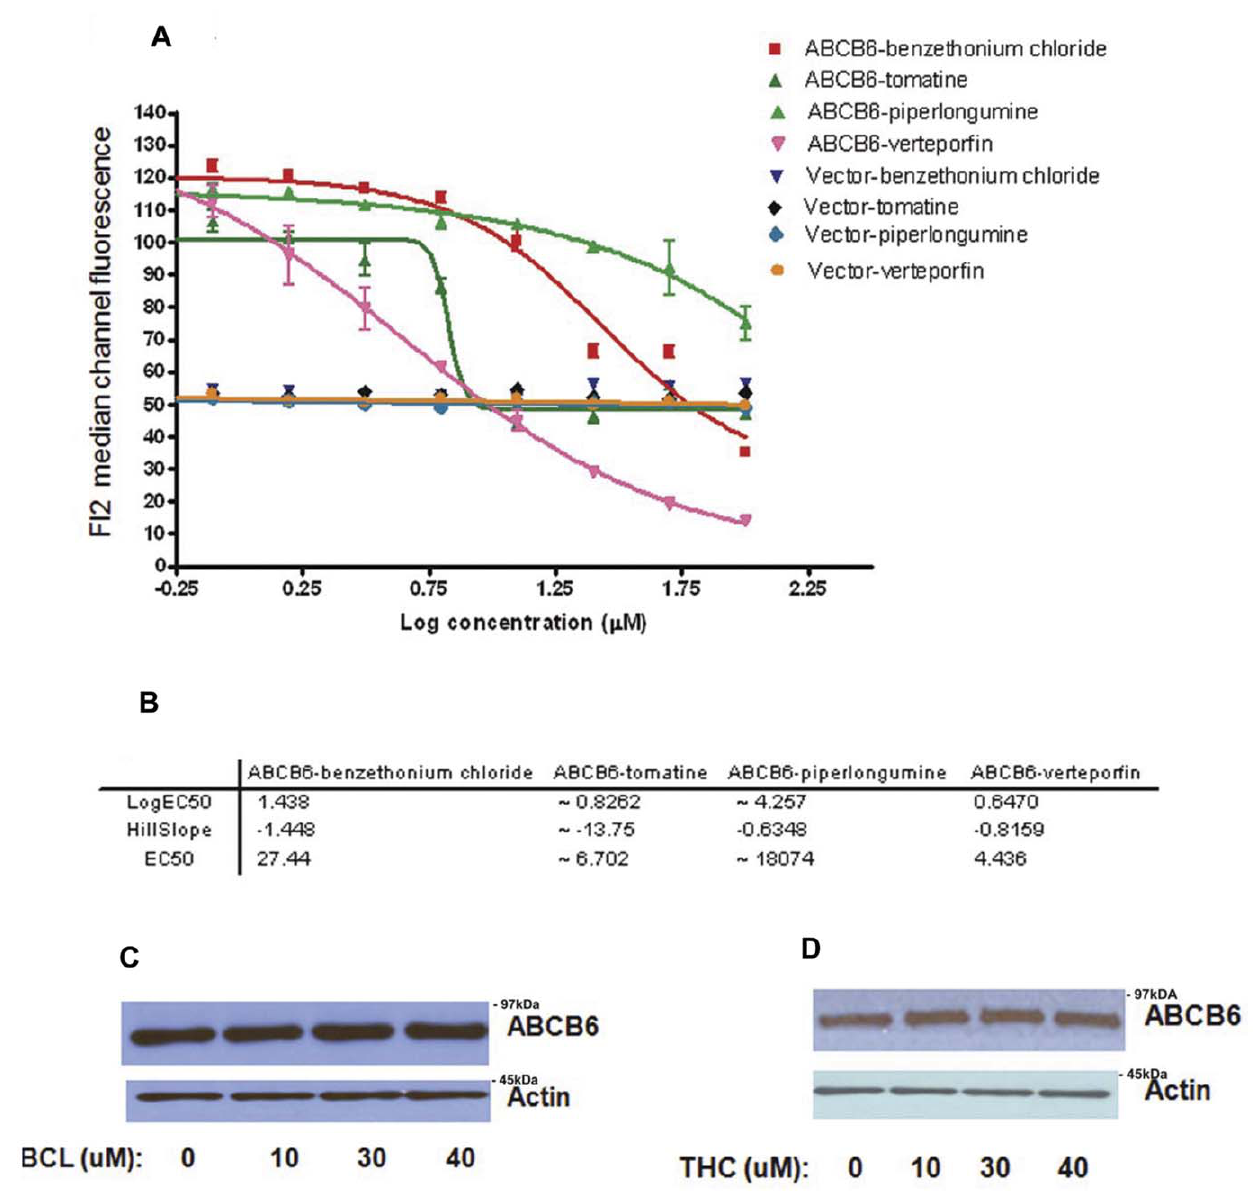
Figure 2. Dose response analysis of active compounds identified in the primary HTS. (a) ABCB6 expressing cells showed dose dependent decrease in median channel fluorescence (representing PPIX fluorescence) in response to benzethonium chloride, verteporfin, and to a lesser extent piperlongumine. In contrast vector control cells did not show any change in median channel fluorescence of FL2 (representing PPIX fluorescence) in response to treatment with any of the four compounds. (b) EC 50 values for each of the compound and their corresponding hillslope values. Results represent mean + / 2 SD with n=3. (c and d) compounds identified in the primary HTS screen do not alter ABCB6 expression in the ABCB6 over- expressing cells. (c) immunoblot analysis of ABCB6 expression in ABCB6 overexpressing cells treated with increasing concentration of benzethonium chloride (BCL). (d) immunoblot analysis of ABCB6 expression in ABCB6-flag overexpressing cells treated with increasing concentration of tomatine hydrochloride (THC). In these studies ABCB6 expression was measured using a monoclonal antibody against the flag-tag. Actin is used a loading control. Figure representative of three independent experiments.